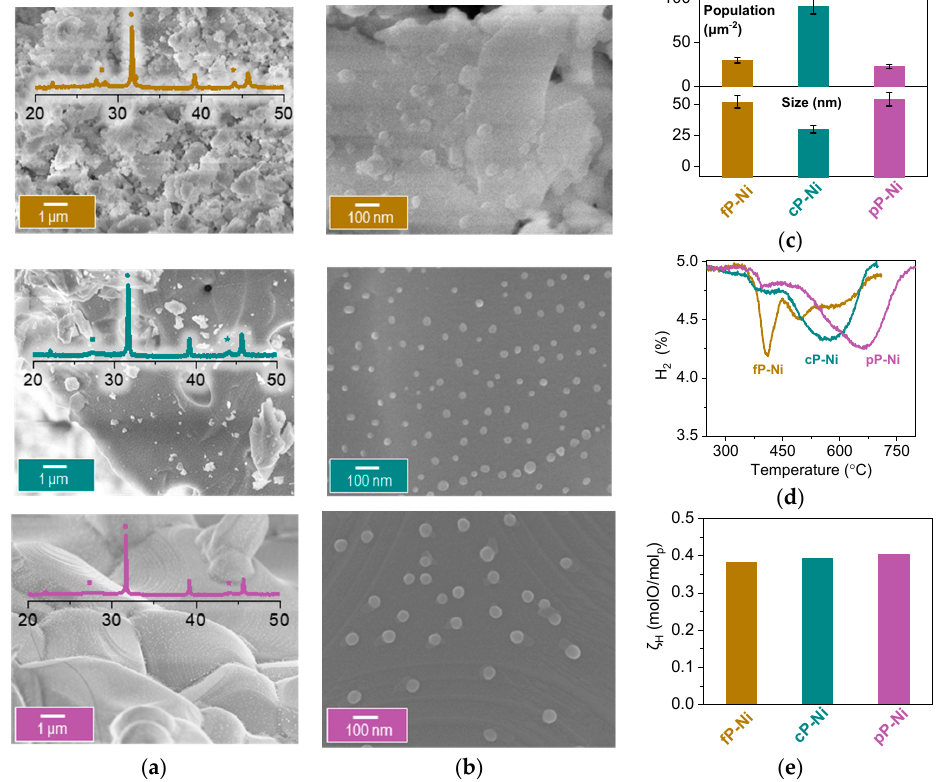
Figure 4. Exsolving from samples with different microstructures. ( a ) Microstructure (SEM) analysis of the fine powder (fP), the coarse powder (cP) and the pellet (pP) after reduction at 1000 C for 10 h. Inserts of XRD patterns of the samples after reduction indicating with ● the main perovskite peak at ~32°, with ∎ the La 2 TiO 5 phase [18] at ~27° and with ∗ the Ni metal peak at ~44°. ( b ) Nanostructure (SEM) analysis of the fP, cP and the pP after reduction at 1000 C for 10 h. ( c ) Particle size analysis and population for the samples. ( d ) Temperature programmed reduction (HTPR) and ( e) ( ζ H ) calculated oxygen capacity from experiment in ( d ).